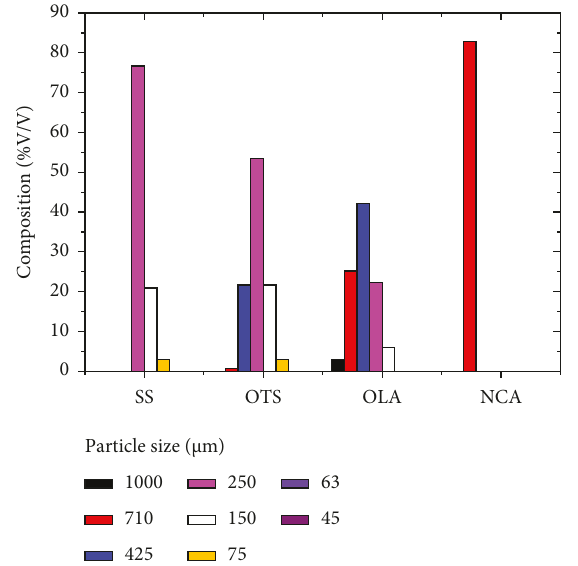
Figure 6: The particle size distribution of SS, OTS, OLA, and NCA